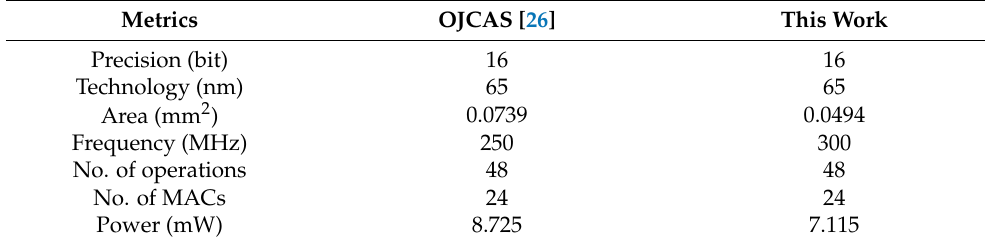
Table 5. Comparison of PE unit.